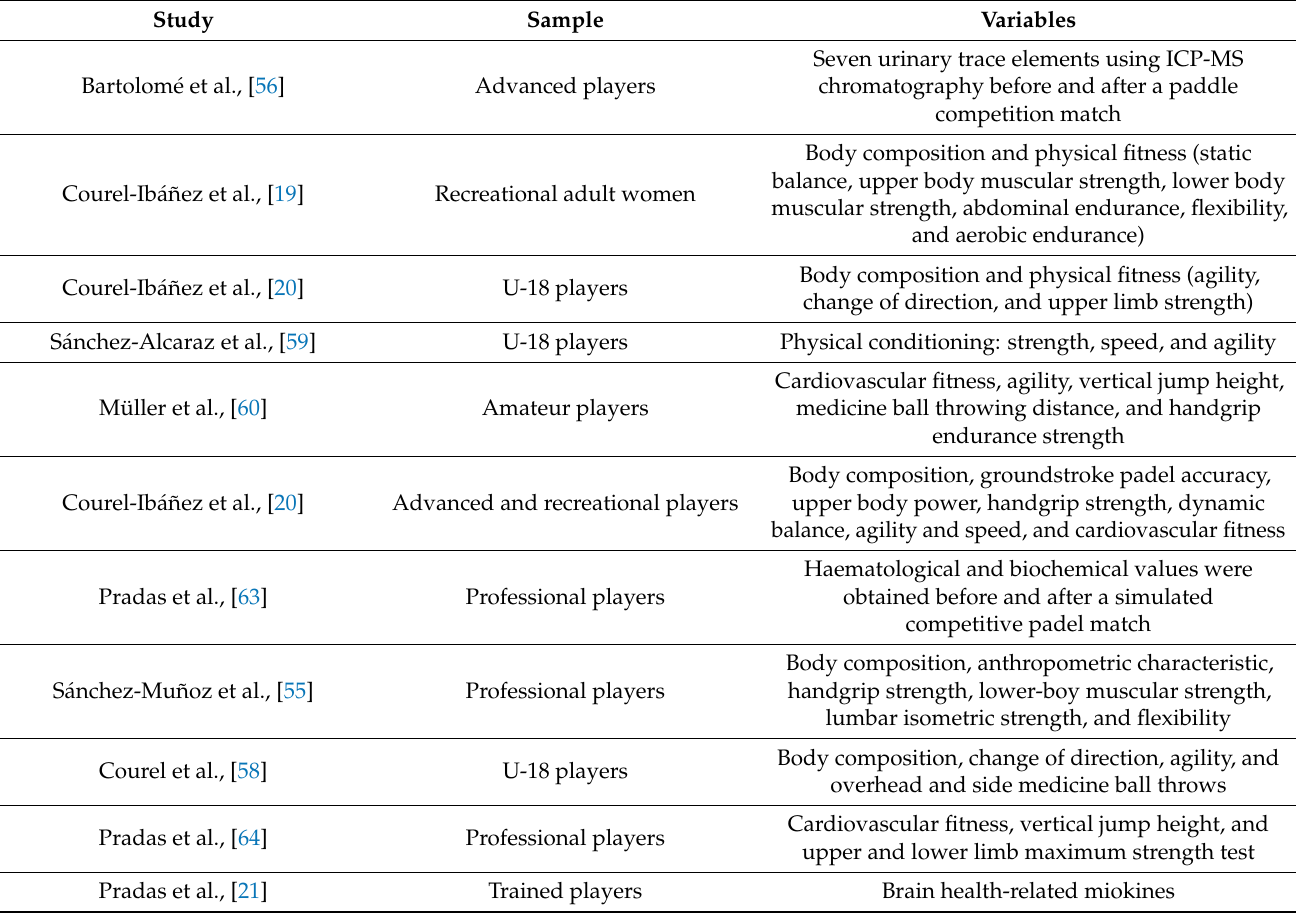
Table 3. Summary of studies exploring fitness, biochemistry, and body composition in padel